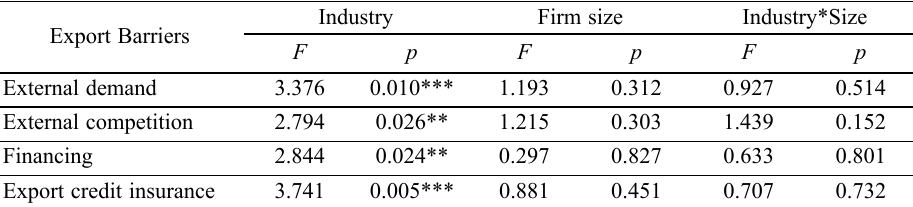
Table 5. Tests of between-subjects